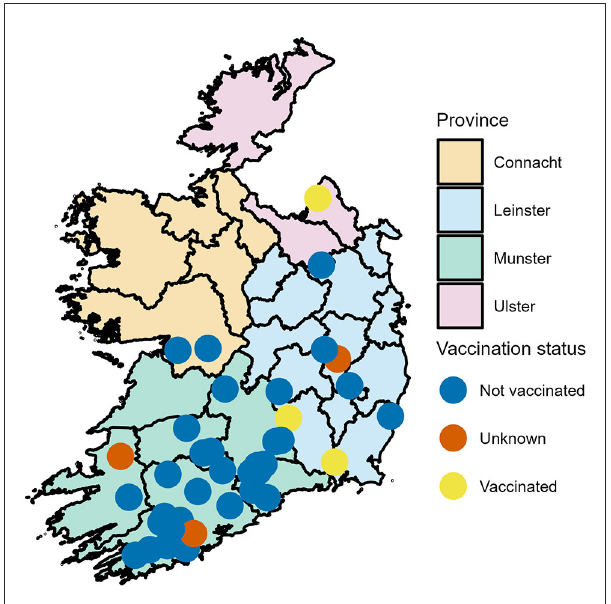
FIGURE1 Geographical distribution of dairy farms enrolled in a calf BRD prevalence study across the Republic of Ireland-Locations have been jitter to mask actual